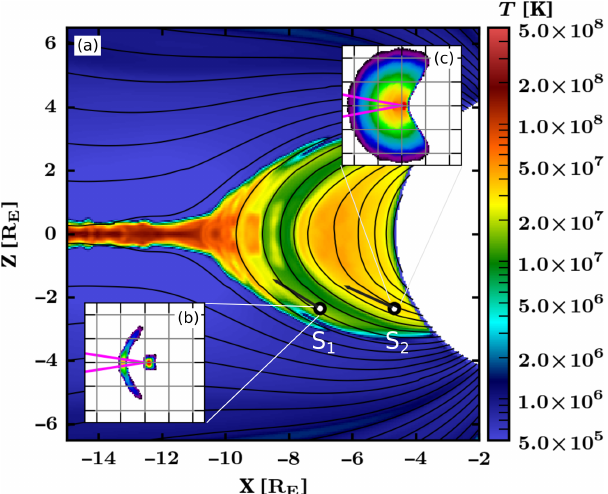
Figure 3. (a) Simulated plasma temperature in the nightside magne- tosphere at t = 1800s. The Sun is located beyond the right bound- ary of the figure. The two black circles filled with white are virtual spacecraft S 1 and S 2 . The arrows indicate the magnetic field di- rections at S 1 and S 2 . (b) Velocity distribution function of protons at S 1 in the ( v B , v B × V ) plane. The grid spacing is 1000kms − 1 . The magenta lines indicate the boundaries of the bounce loss cone. (c) Same for protons at S 2